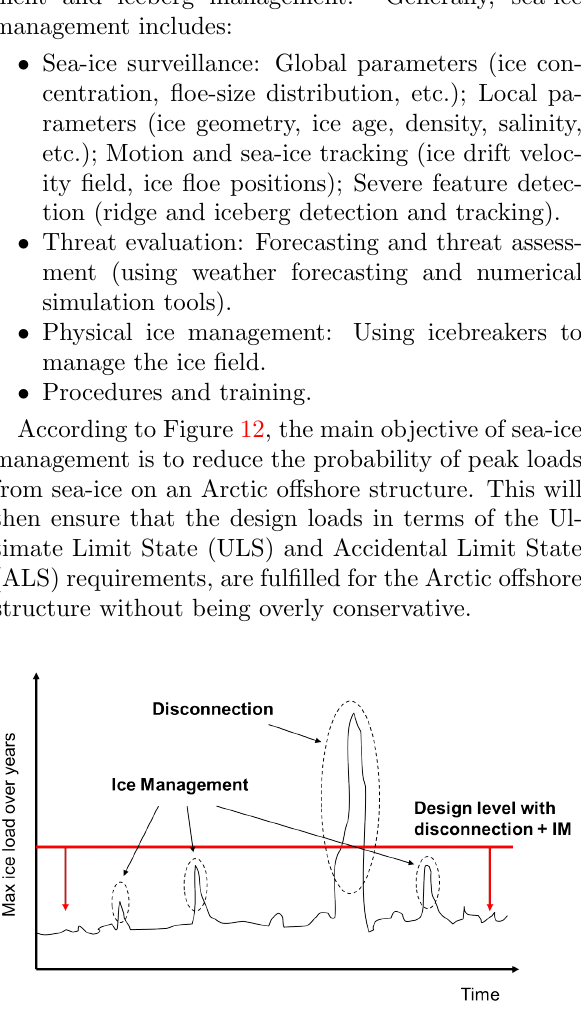
Figure 12: By Ice Management the ice load design